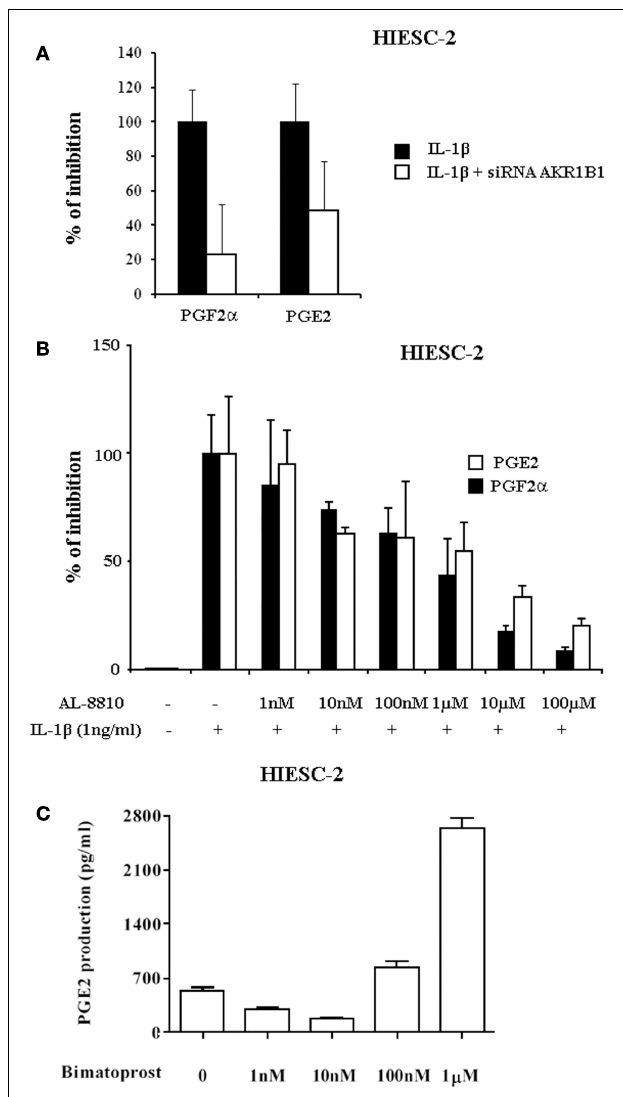
FIGURE 7 | Influence ofAKR1B1 and FP receptor inhibition or stimulation on PG production in human endometrial stromal cells. (A) Normal or AKR1B1 siRNA transfected human endometrial stromal (HIESC-2) cells were grown to confluence and treated with IL-1 β for 24h and PGE2 and PGF2 α were measured in the culture medium. (B) HIESC-2 cells were grown to confluence and treated with IL-1 β for 24h in presence and absence of increasing concentrations of the FP receptor antagonist AL-8810, furthermore PGE2 and PGF2 α were measured in the culture medium. (C) HIESC-2 cells were grown to confluence and treated for 24h with increasing doses of the PGF2 α analog and FP receptor agonist bimatoprost and PGE2 was measured in the culture